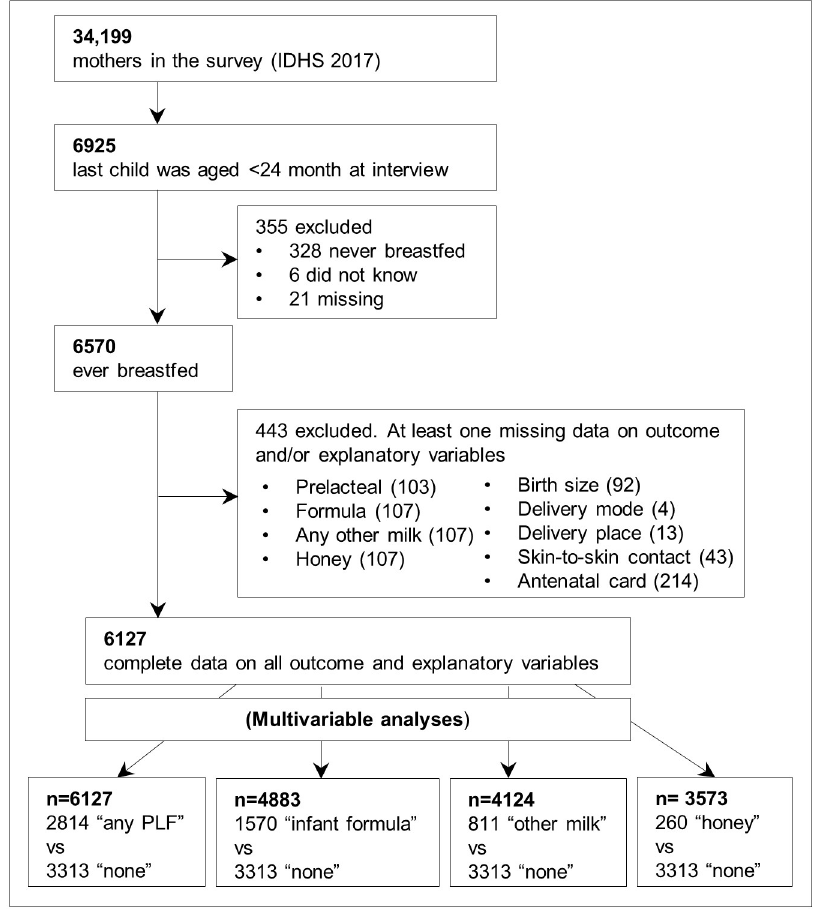
Fig 1. Flow diagram of study population